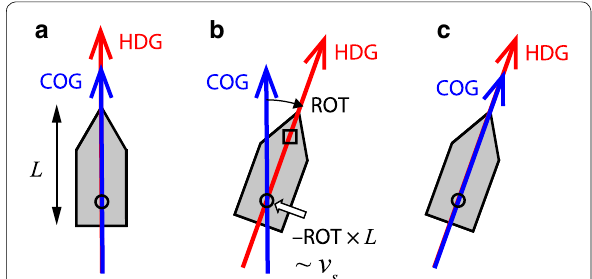
Fig. 5 Schematic diagram of apparent sway velocity ( v s ) due to ship yawing of forwarding ship whose ship length is L . Open square and open circles indicate the pivot point of the ship and the GNSS antenna, 1990; Yoshimura and Ma 2003; Yoshimura and Masu- moto 2011) in which A ~ 1.0 corresponds to the distance between the pivot point and the rudder at stern.